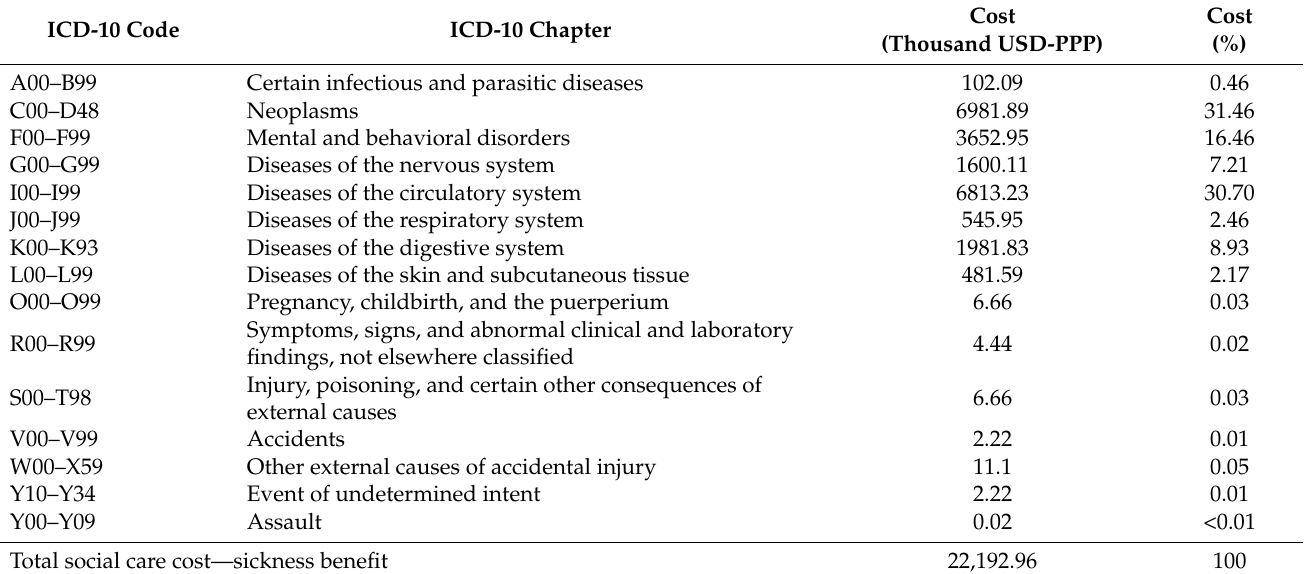
Table 7. Social care cost attributable to alcohol—sickness benefit in percentage,